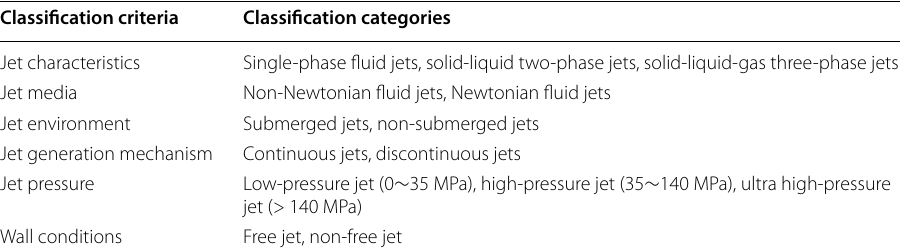
Table 1 Classification of water jets Classification criteria Classification categories